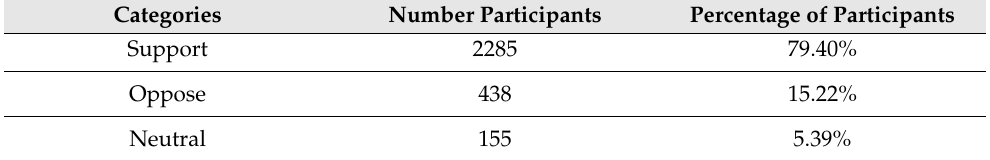
Table 2. UWA Mandate